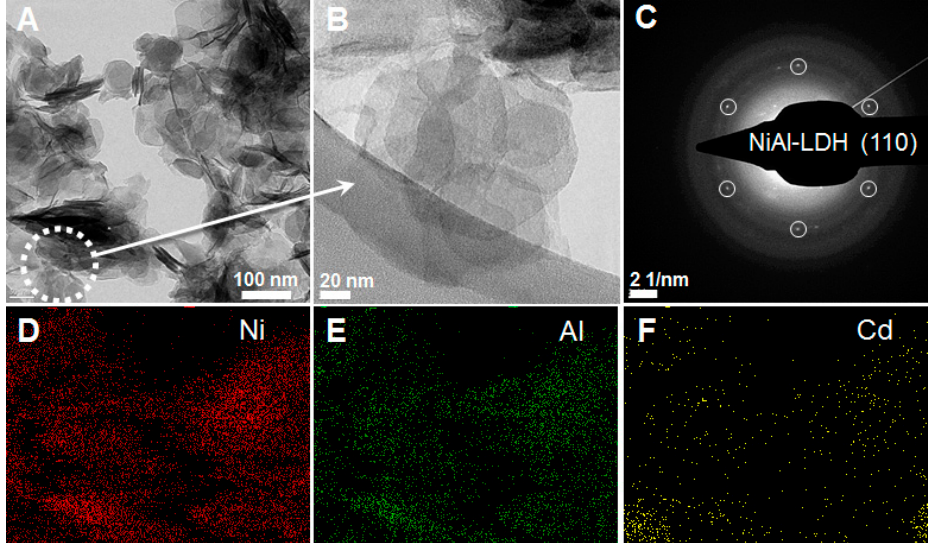
Figure 3. ( A ) HRTEM image of 1D/2D hybrid ; ( B ) Larger magnification of the hexagonal crystals; ( C ) SAED exhibiting a hexagonal arrangement of the diffraction peaks, as expected from the intrinsic symmetry of the LDH layers; ( D – F ) HRTEM-EDS elemental mapping performed over the area corresponding to ( A ) showing the homogeneous distribution of Ni, Al and Cd in the 1D/2D hybrid material.